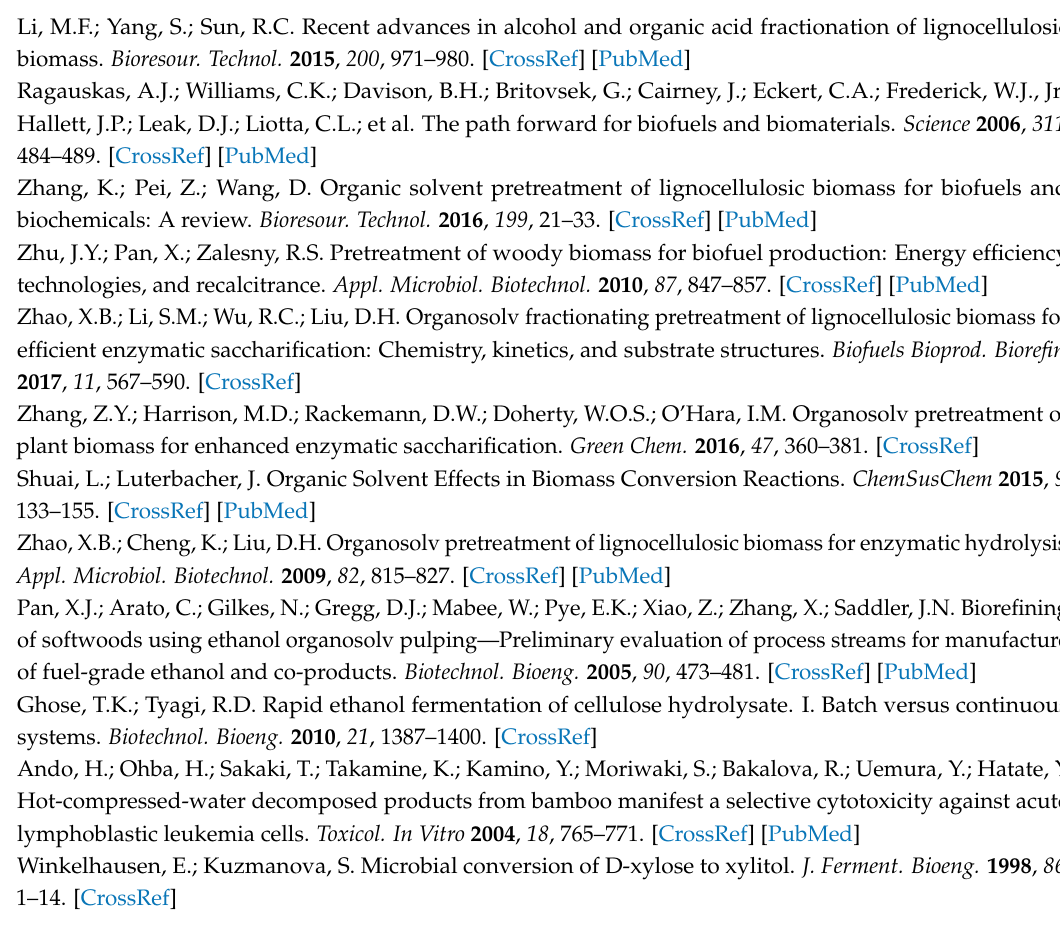
Figure S1: The relationship between ln(1 − R x /100) and t at EACO pretreatment temperature of (a) 443, (b) 458 and (c) 473 K , Figure S2: pH value of pretreatment liquor at EW pretreatment temperature of (a) 443, (b) 458 and (c) 473 K with different ethanol content in pretreatment medium, Figure S3: Comparisons of measured and model predicted data under different conditions of EACO pretreatments: (a) xylan removal; (b) xylo-oligosaccharides and (c) xylose concentration, Figure S4: The relationship between experimentally measured “d x ” and its predicted value, Figure S5: The relationships between measured and predicted concentration of degradation products: (a) F and (b) AA, Figure S6: The relationship between experimentally measured xylan and lignin